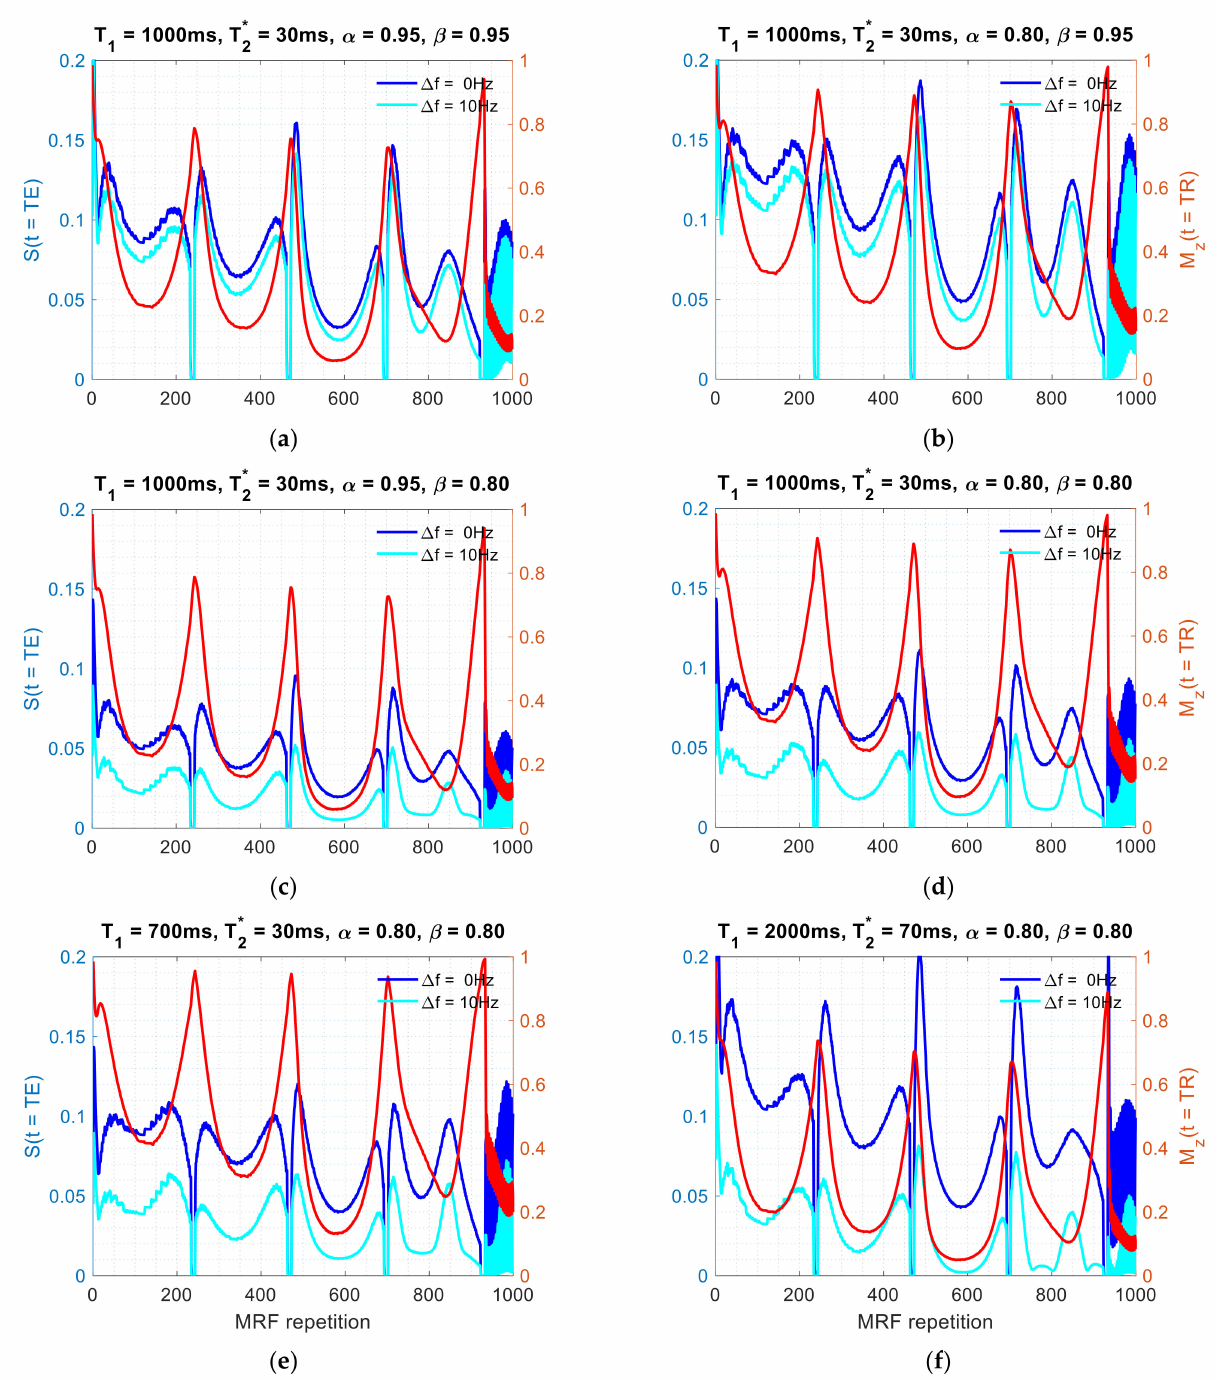
Figure 2. The MRF signal (i.e., S ( t ) in blue) and spin–lattice magnetisation (i.e., M z (t) in red) evolves as a function of MRF repetition. The MRF signal is acquired at t = TE and magnetisation evolves until t = TR before the sequence is repeated for a new flip angle (i.e., θ ) and TE and TR. T 1 and T ∗ values have been chosen in view of representative values in the human 2 brain. Displayed are time fractional Bloch equations simulations when ( a ) α and β are close to the integer order case and effects of changing ( b ) α , ( c ) β , ( d ) both α and β , ( e ) T 1 and ( f ) both T 1 and T ∗ are depicted. In each case, a distinct change in 2 ∆ f has been plotted as